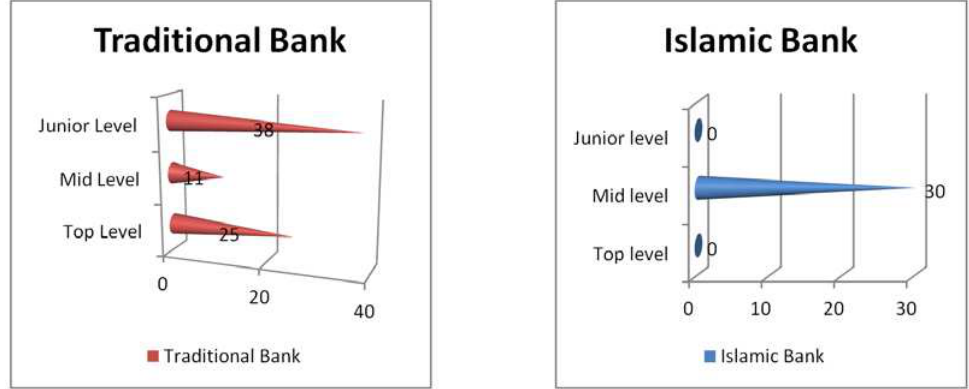
Fig. 4. Government involvement regarding